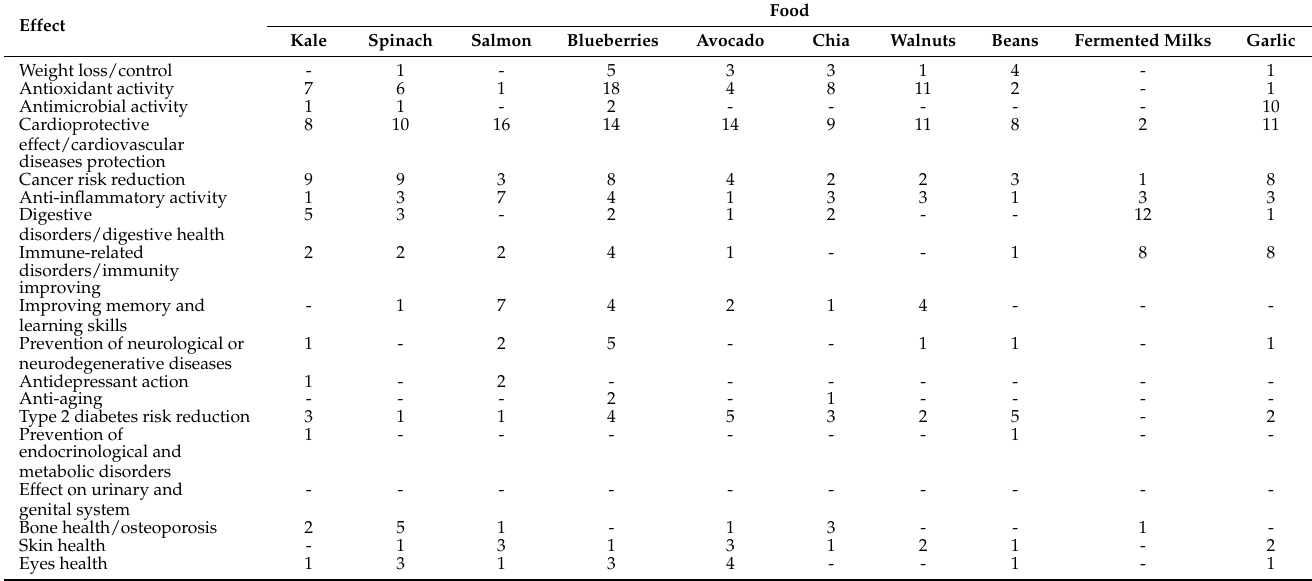
Table 12. Effects on health and disease prevention of ‘superfoods’ and number of selected web sites that mentioned each